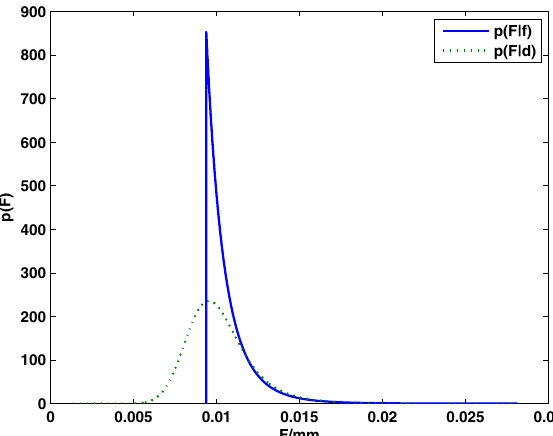
Fig. 1. Posterior densities p ( F | f ) and p ( F | d ) derived ac- cording to models (1) and (3)–(4), respectively, for eight ob- servations generated at random with F = 0 . 010 mm and σ M = 0 . 002 mm.